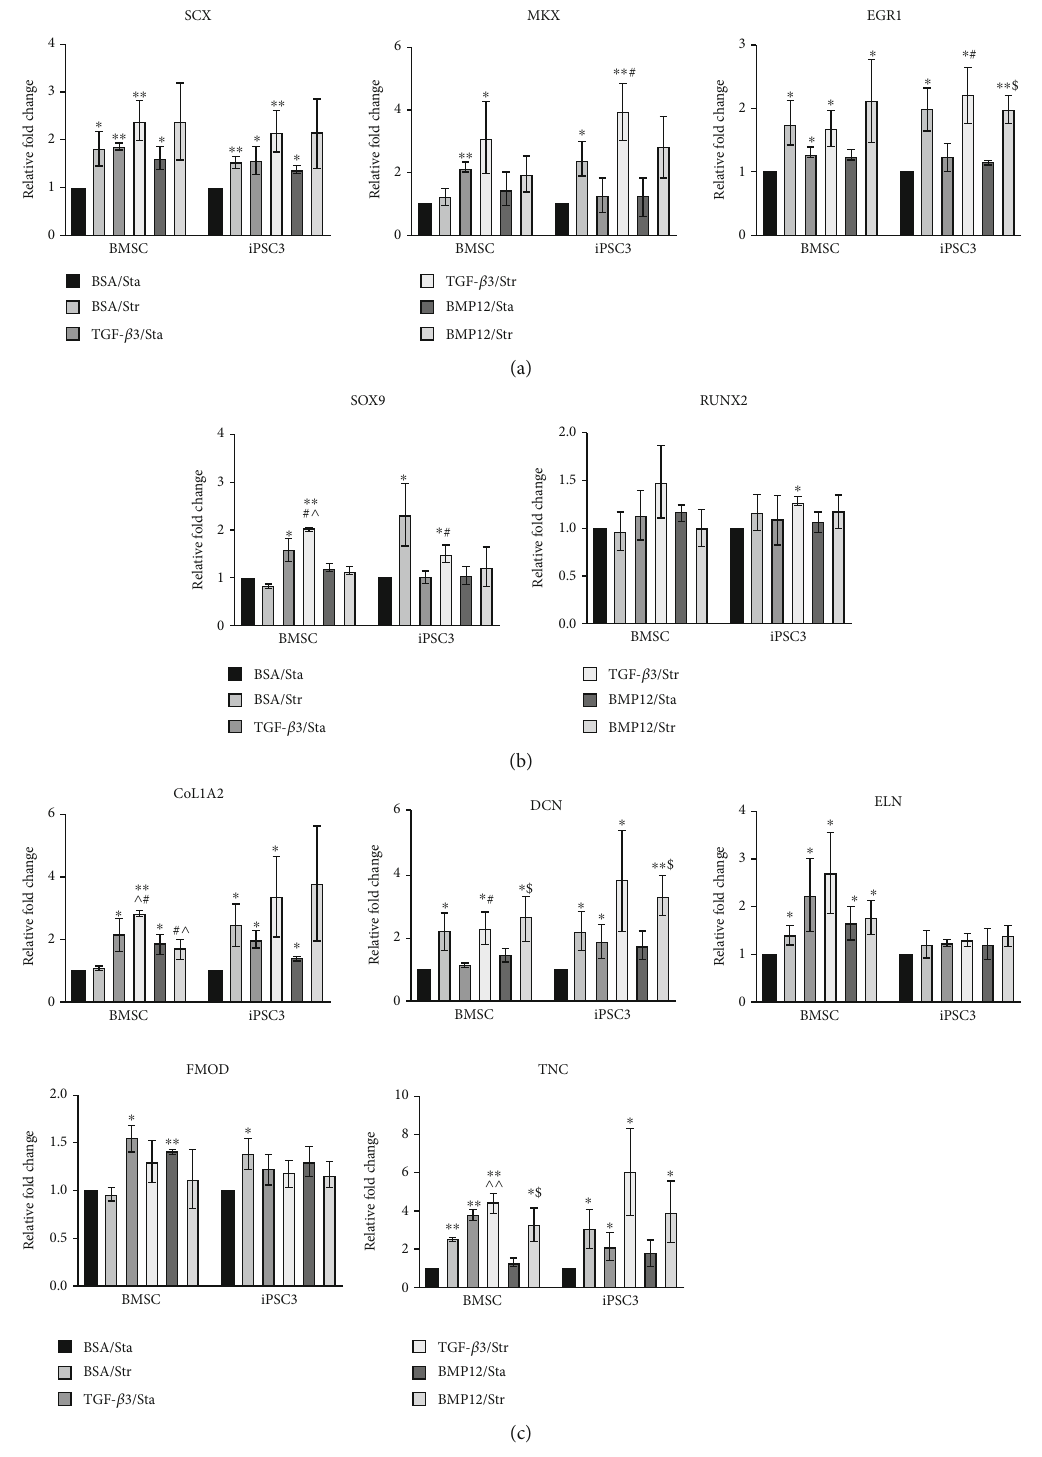
Figure 5: E ff ects of cyclic uniaxial mechanical stretch on gene expression in TGF- β 3- or BMP12- treated BMSCs and teno-iPSCs. BMSCs and teno-iPSCs were seeded on vitronectin-coated PCL sca ff olds for 2 days in basic medium, and then treated with vehicle medium, TGF- β 3, or BMP12 for 2 days prior to uniaxial mechanical stretch for 18 hours in the presence of vehicle medium (BSA/Str), TGF- β 3 (TGF- β 3/Str), or BMP12 (BMP12/Str). Cells seeded on PCL sca ff olds without mechanical loading but with vehicle medium (BSA/Sta), TGF- β 3 (TGF- β 3/Sta), or BMP12 (BMP12-Sta) were served as static control. Expression of tenogenic transcription factors (a), SOX9 and RUNX2 (b), and tenocyte- related ECM genes (c) was determined by qPCR, and relative fold change for each group was calculated by comparison to BSA/Sta group. ∗ Data were compared to the BSA control group; ^ data were compared to BSA/Str; $ data were compared to